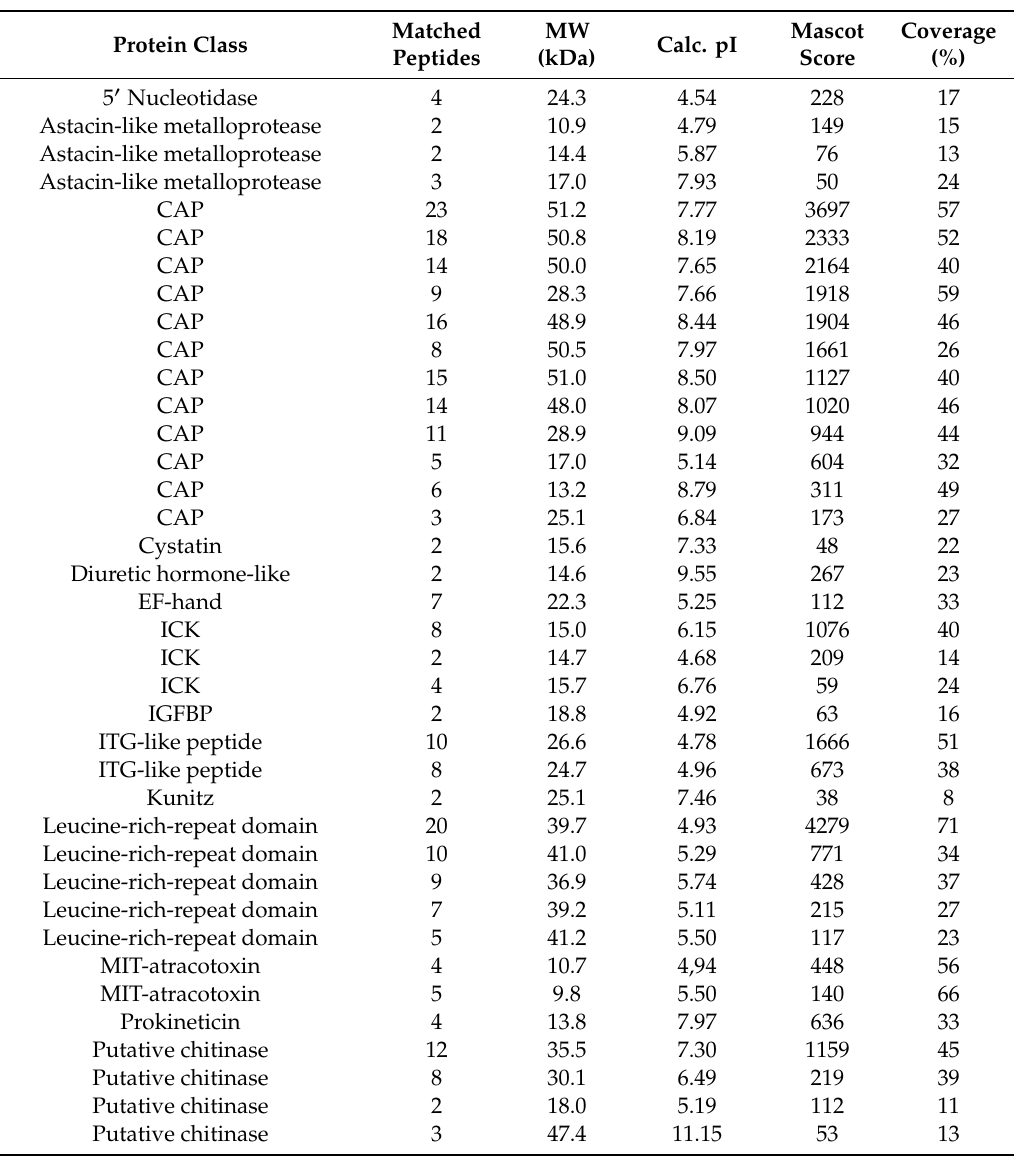
Table 2. Identification of A. bruennichi venom proteins by liquid chromatography electrospray ionization (nanoLC-ESI)-MS. The analysis of peptide fragments allowed us to identify protein groups with putative venom functions, representing 20 di ff erent protein families. Confirming the parallel MALDI-TOF-MS analysis, most proteins could be assigned to the CAP superfamily. ICK = inhibitor cysteine knot and IGFBP = insulin-like growth factor binding